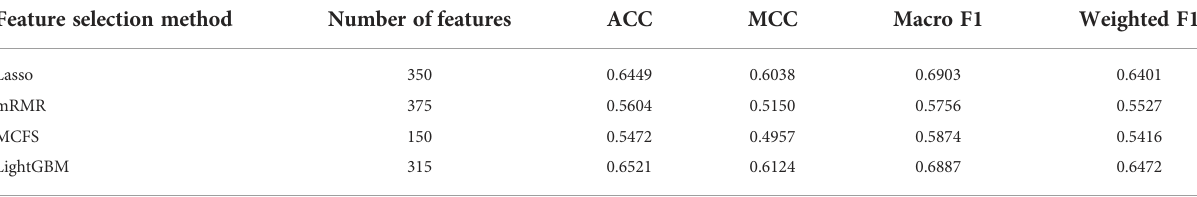
TABLE 3 Performance of the feasible SVM classi fi ers for different feature selection methods. Feature selection